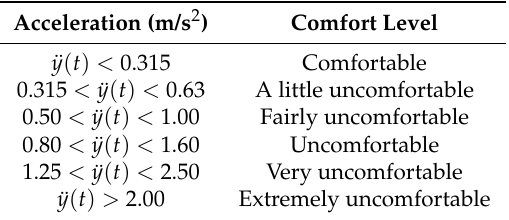
Table 1. Range of acceleration of the unsprung vehicle mass and the corresponding comfort levels as per ISO 2631-1